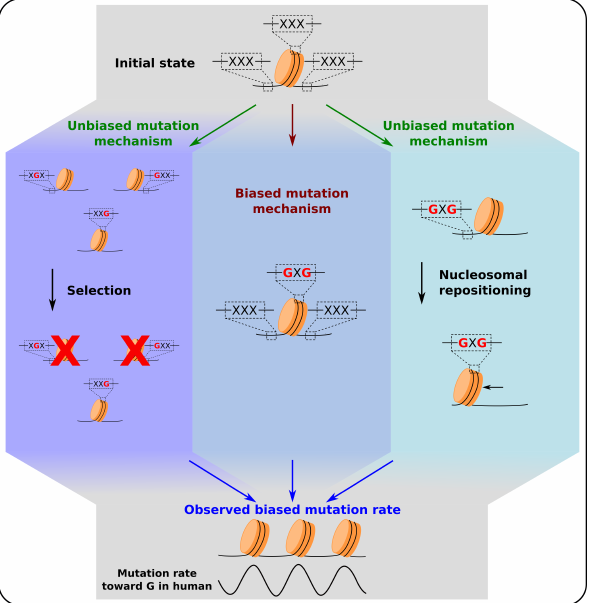
Figure 3. Source of biased mutation rates relative to nucleosomal positioning. Three mechanisms that can lead to biased mutation rates relative to nucleosome positioning as described in Sections 3 and 4. ( Left ) Mutations that facilitate the positioning of nucleosomes at specific loci are positively selected, those favoring alternative positions are purified. Such mechanism is for example observed at yeast promoters (Section 3.2). ( Center ) A biased mutation mechanism where the presence of a